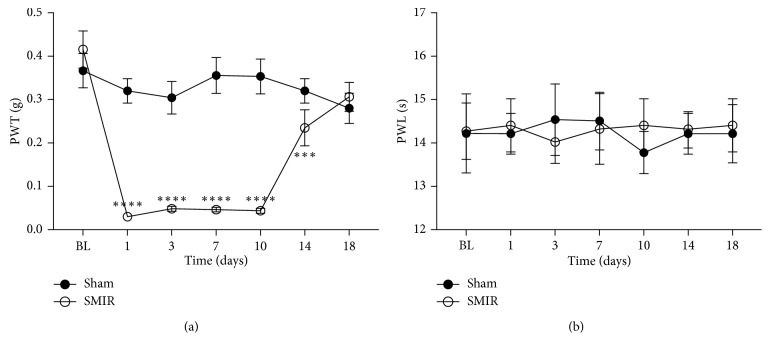
Paw withdrawal threshold (PWT) for mechanical stimulation and paw withdrawal latencies (PWLs) to noxious heat stimulation evoked by skin/muscle incision and retraction (SMIR) surgery. (a) The sham treatment group did not demonstrate significant mechanical hypersensitivity as compared to baseline, to von Frey stimulation in the ipsilateral paw. SMIR surgery evoked a persistent significant mechanical hypersensitivity. SMIR-evoked mechanical hypersensitivity in the ipsilateral paw (two-way RM ANOVA, sham versus SMIR: F1; 16 = 50.6, P < 0.0001; time: F6; 96 = 15.42, P < 0.0001, interaction: F6; 96 = 15.48, P < 0.0001; n = 9 for the sham group, n = 9 for the SMIR group; ∗∗∗P < 0.001, ∗∗∗∗P < 0.0001 under Sidak's multiple comparisons test). (b) Paw withdrawal latencies in the sham-operated group were unaltered throughout the time course. SMIR surgery also did not evoke significant heat hypersensitivity. Withdrawal latencies of the ipsilateral paws in the SMIR-operated mice were not significantly altered up to postoperative day 18 (two-way RM ANOVA, sham versus SMIR: F1; 17 = 0.013, P=0.91; time: F6; 102 = 0.07, P=0.999, interaction: F6; 102 = 0.23, P=0.97; n = 9 for the sham group, n = 10 for the SMIR group, under Sidak's multiple comparisons test). ANOVA, analysis of variance; RM, repeated measures; BL, presurgery baseline.